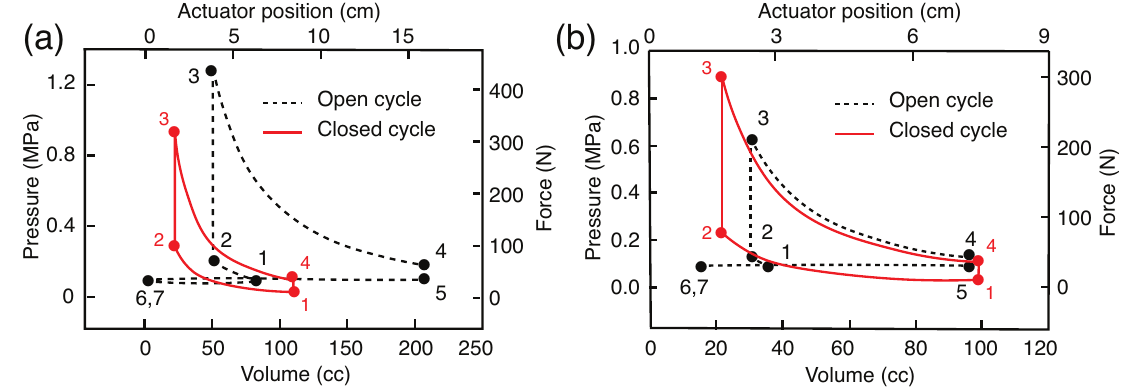
Figure 4. Open and closed cycle pressure-volume and force-displacement diagrams for ( a ) the reference actuator ( b ) an actuator with b = 27.5 N-s/m, b p = − 40 N-s/m and φ =